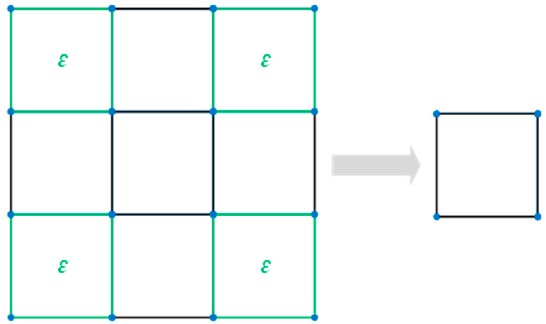
Figure 9. Node merging for enhanced current capabilities.